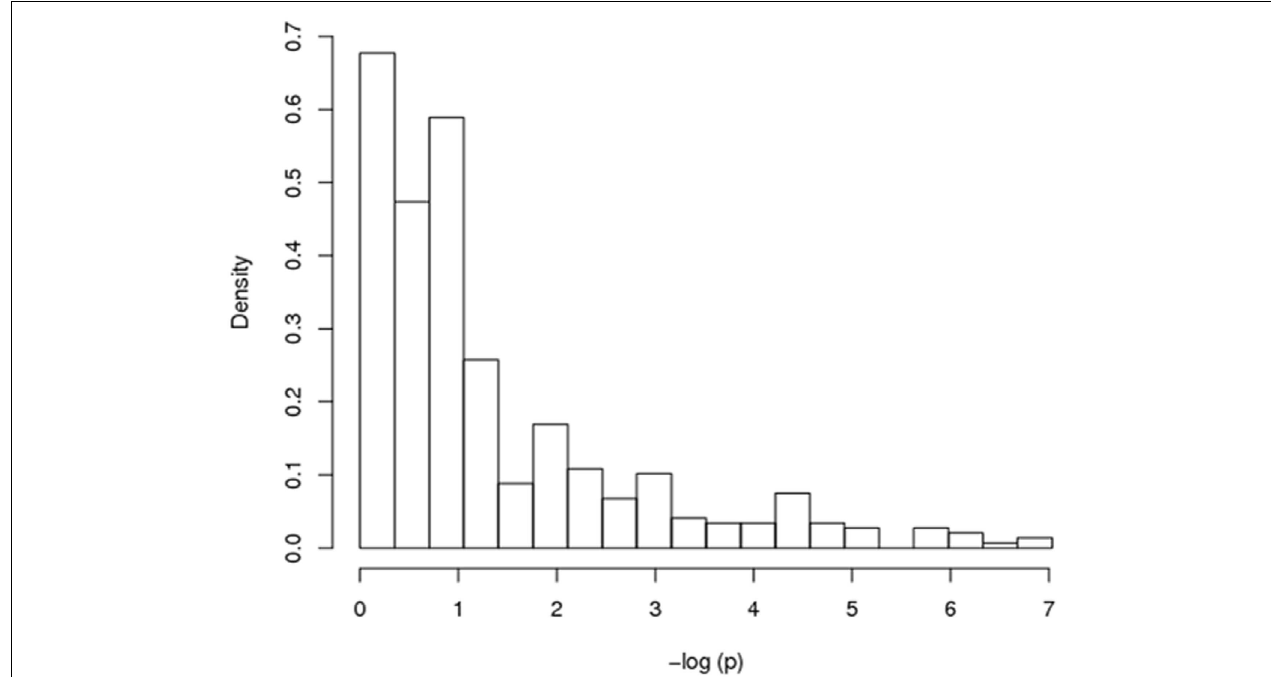
FIGUREA2 | Distribution of p -values of the tocopherol